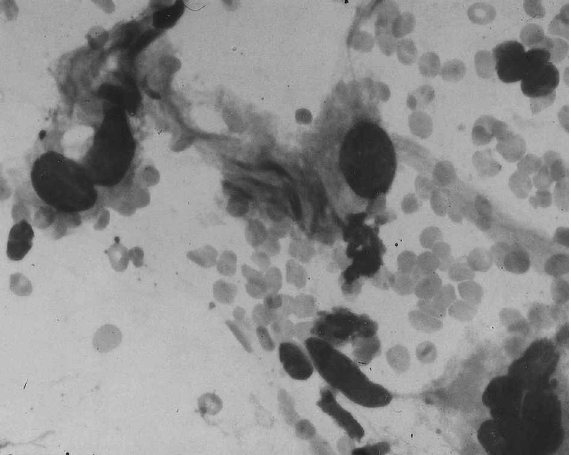
Fig. 6. Part of an aspirate from an ancient neurilemoma. A low-grade malignant spindle cell sarcoma (leiomyosarcoma or malignant peripheral nerve sheet tumour) may display similar cellular features . (MGG 3